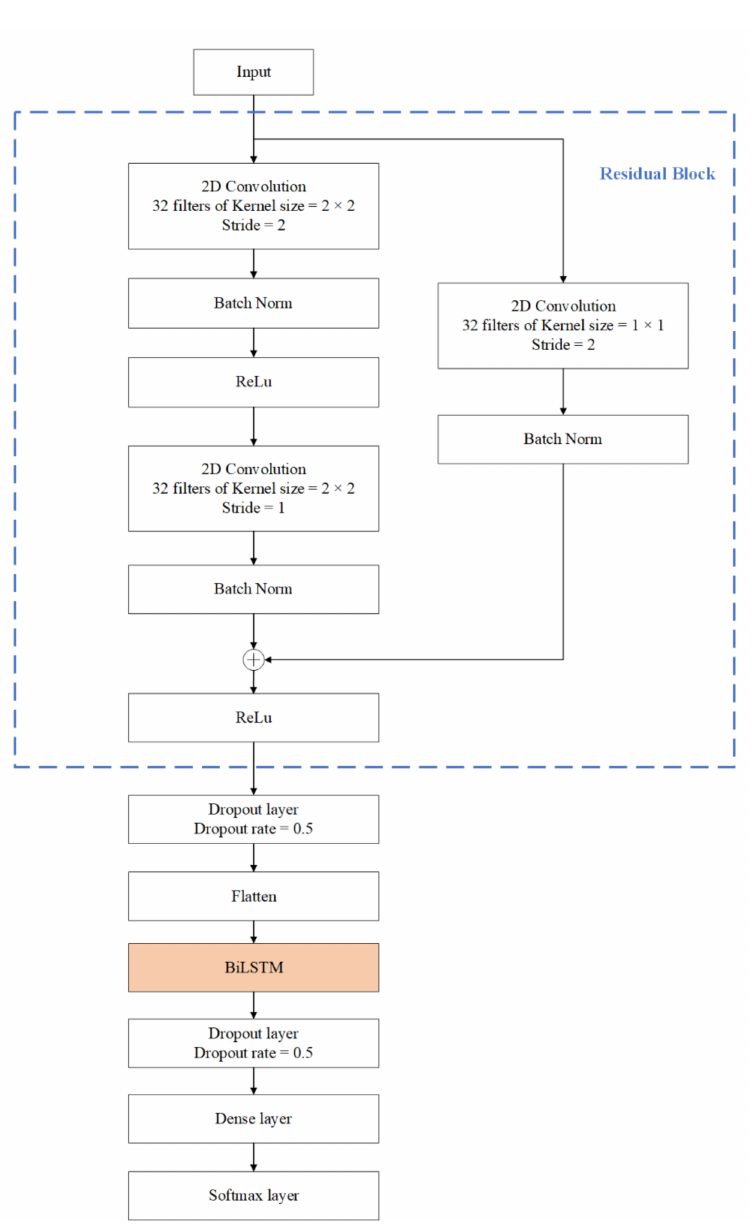
Figure 2. Frame diagram of the proposed